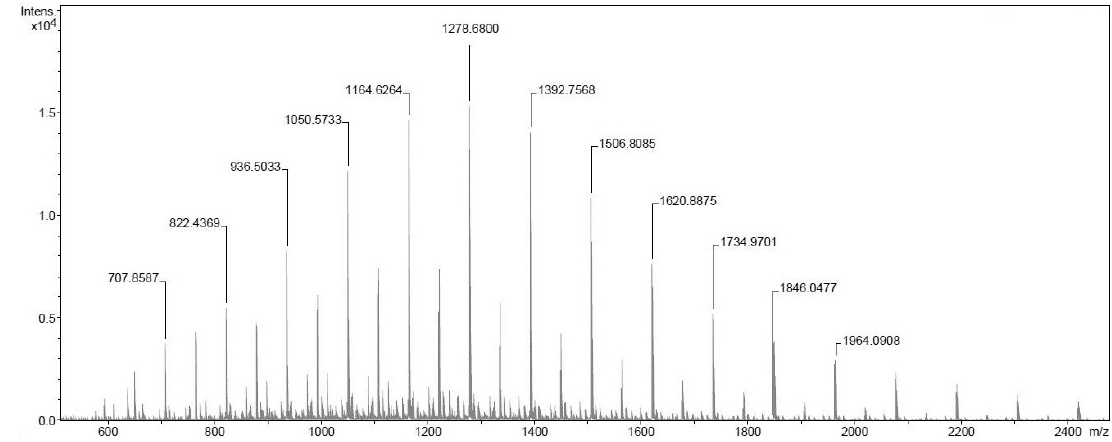
Figure 2. Mass spectra of synthesized lamivudine–poly- ε -caprolactone conjugate. Molecules 2019 , 24 , 723